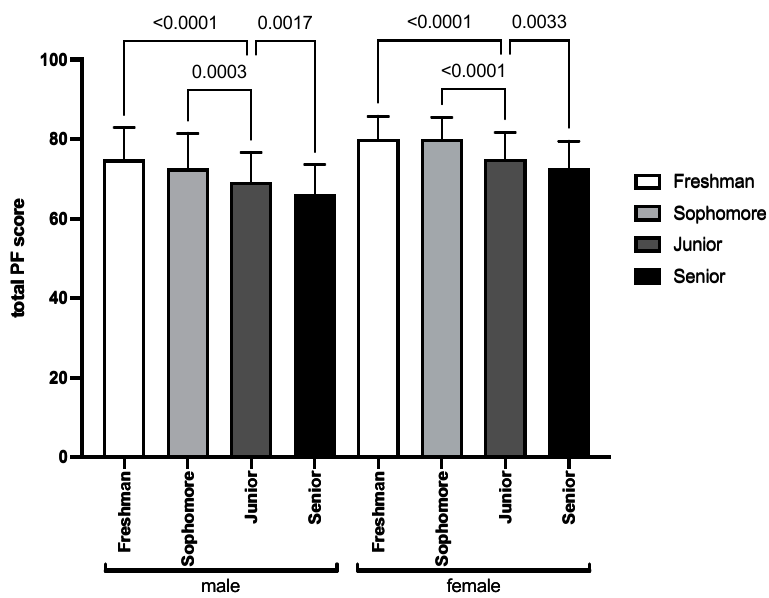
Figure 4. The total PF score in different academic years in males and females.